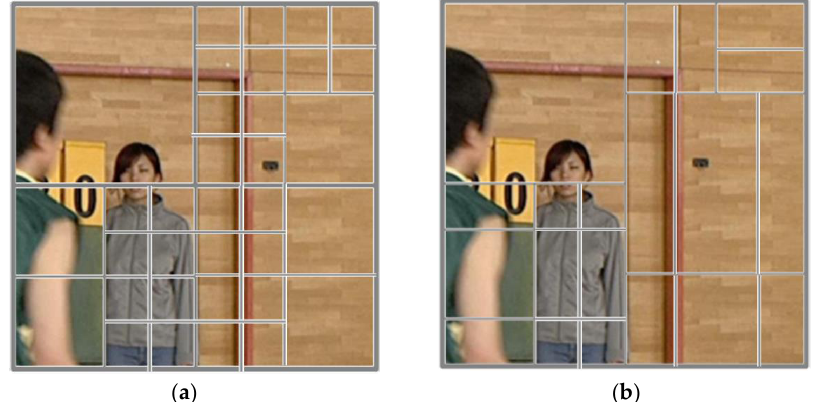
Figure 4. Block partitioning: ( a ) QT in HEVC/H.265 and ( b ) QT/BT/TT in VVC/H.266.